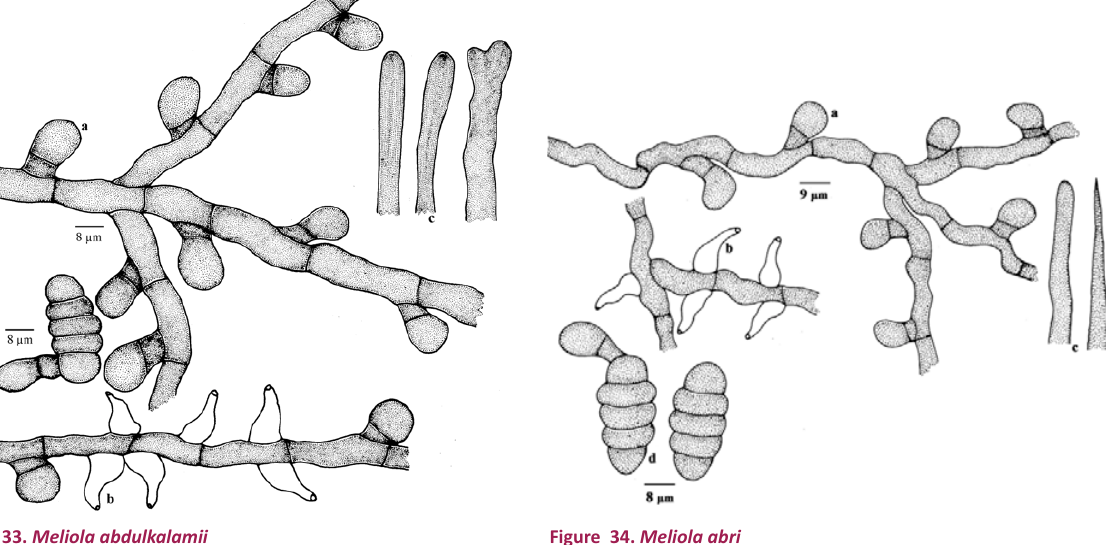
Figure 33. Meliola abdulkalamii a - Appressorium; b - Phialide; c - Apical portion of mycelial setae; d - Ascospores